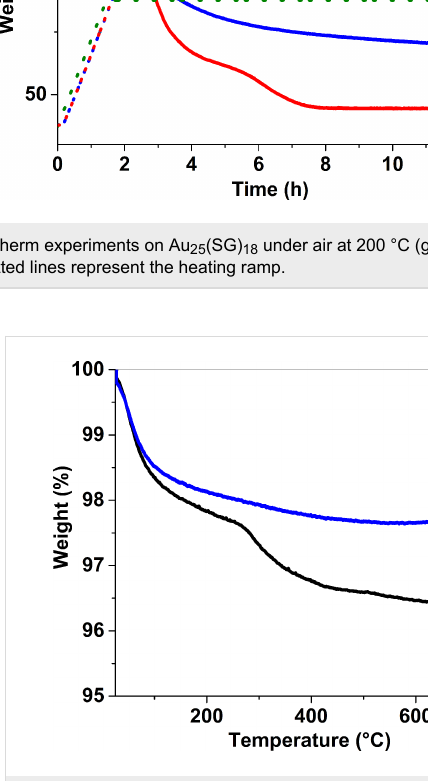
Figure 2: TGA experiments on Au 25 (SG) 18 deposited on ZrO 2 (black) and ZrO 2 alone (blue) carried out under air at 10 °C/min.